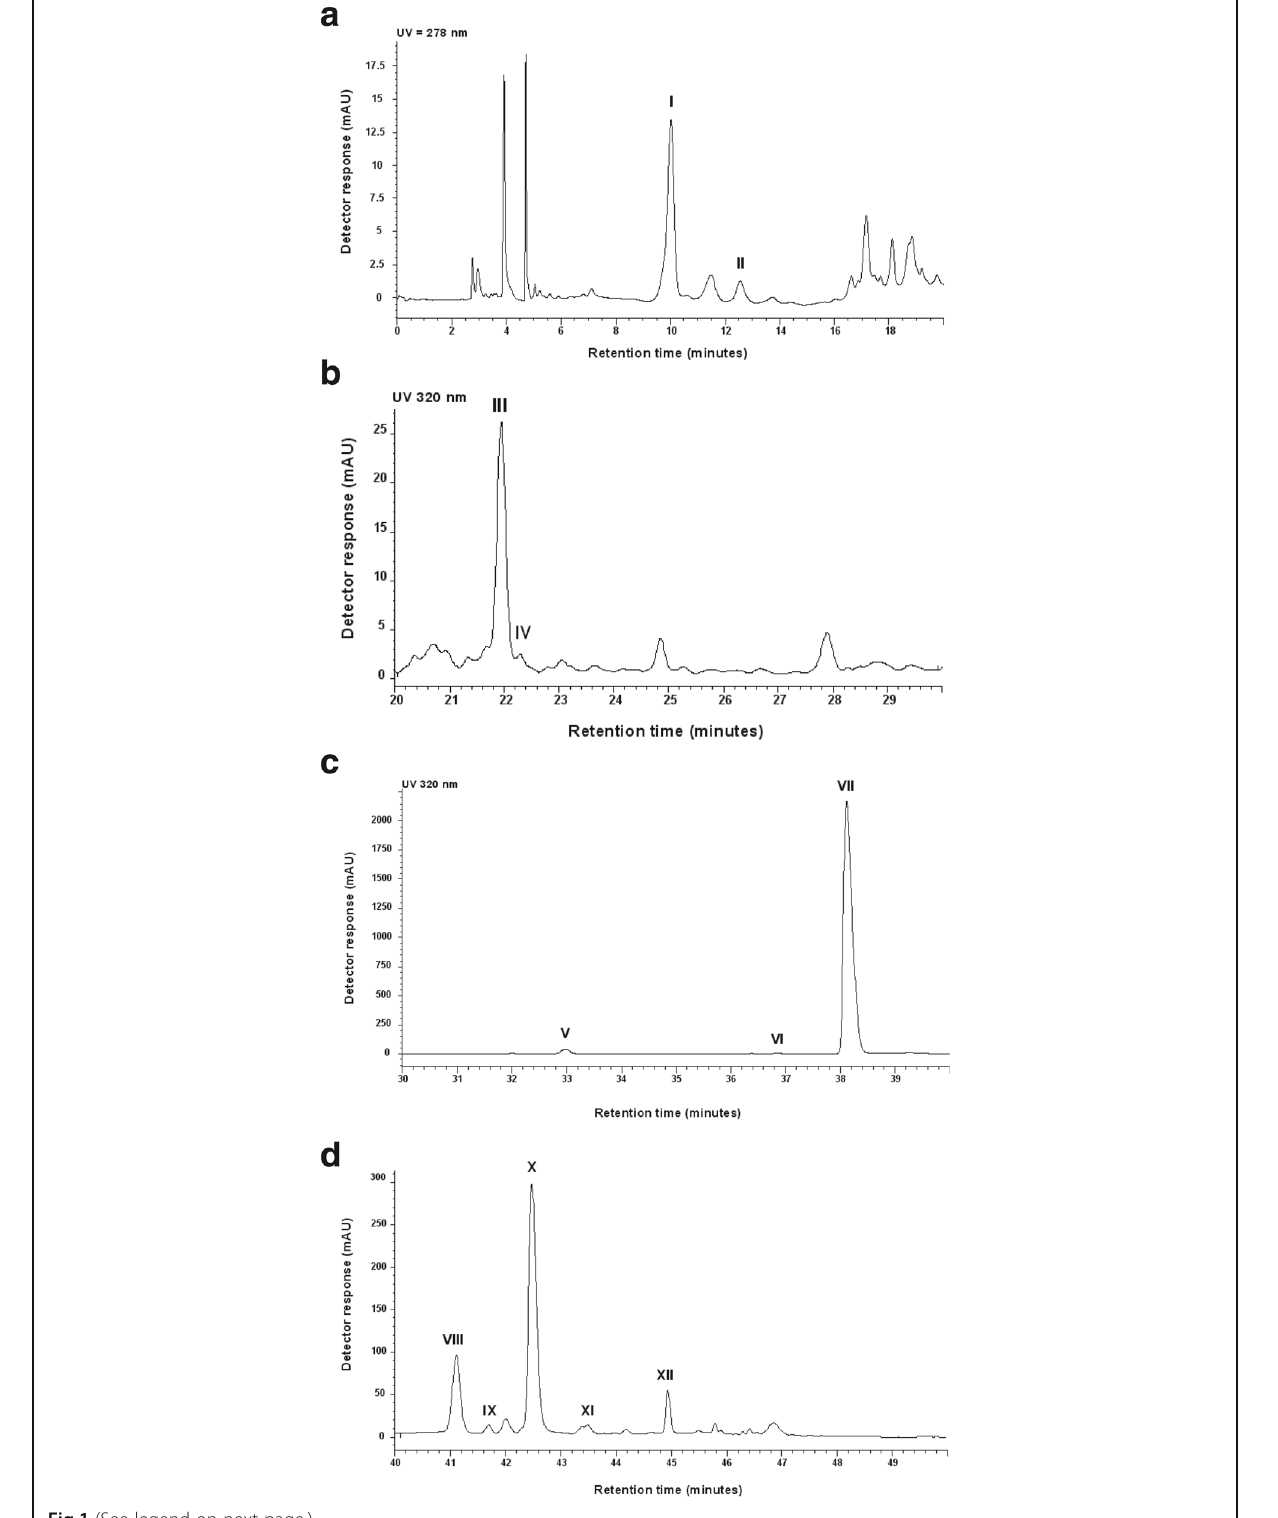
Fig.1 (See legend on next